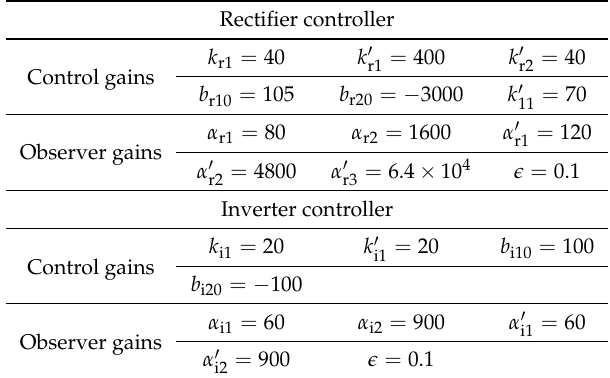
Table 2. Controller parameters used in the Section